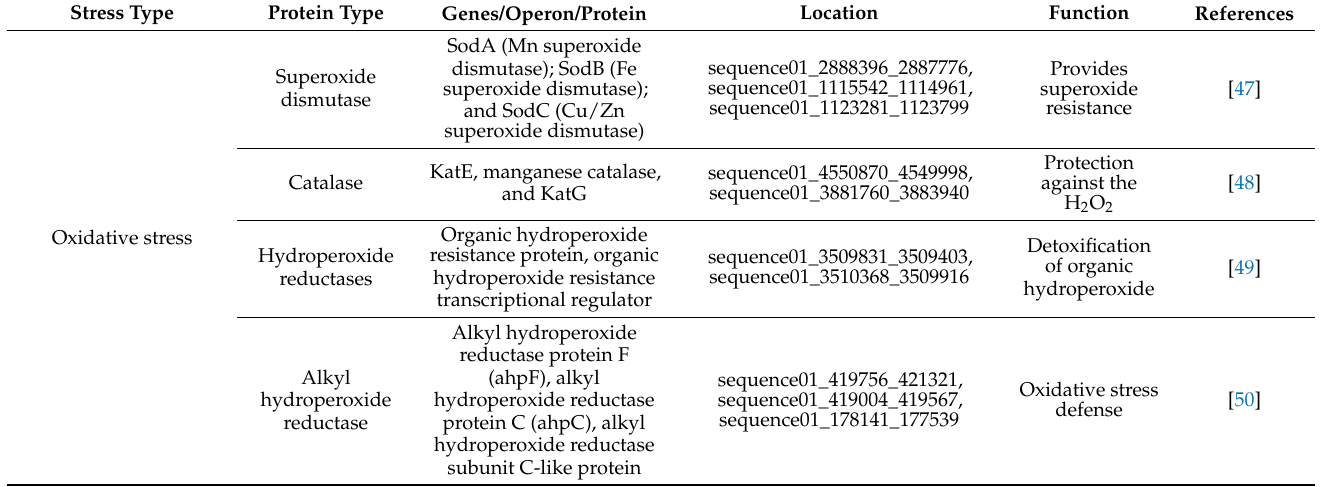
Table 1. The genes predicted to be involved in different stress adaptation